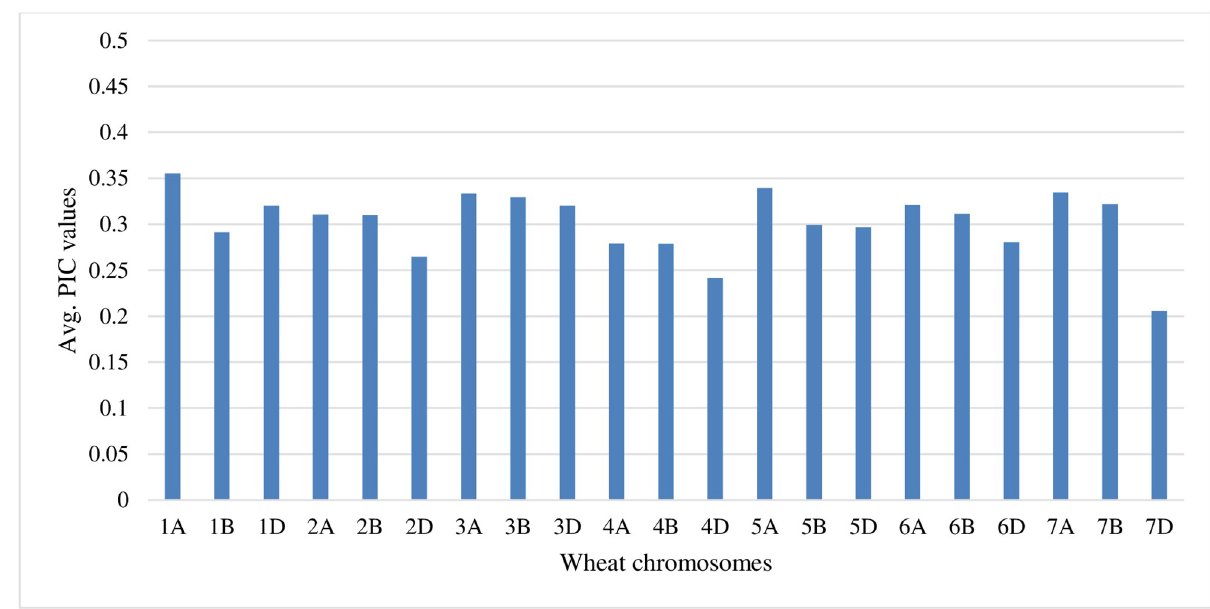
Fig 3. Average PIC values per chromosome. The Y axis depicts the average PIC values from the polymorphic SNP markers and the X axis shows the wheat chromosomes.